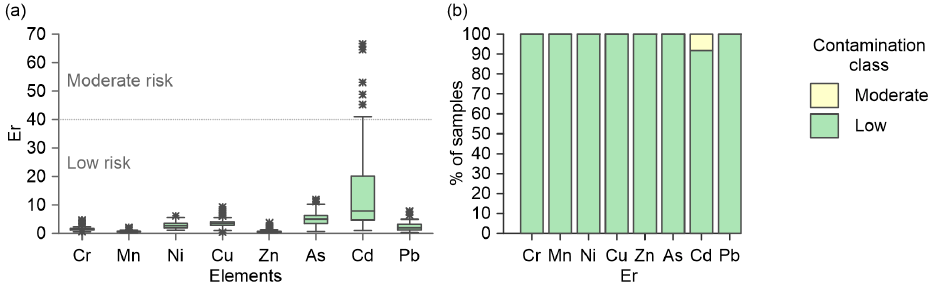
Figure 2. Boxplots of ( a ) potential ecological risk factors (Er) for PTEs in topsoils of the Lower Don floodplain and Taganrog Bay coast and ( b ) soil contamination class percentages. The boxes represent interquartile range (IQR), the line inside the box is the median, whiskers are rated as IQR *1.5, outliers (>IQR *1.5) were shown by asterisks.